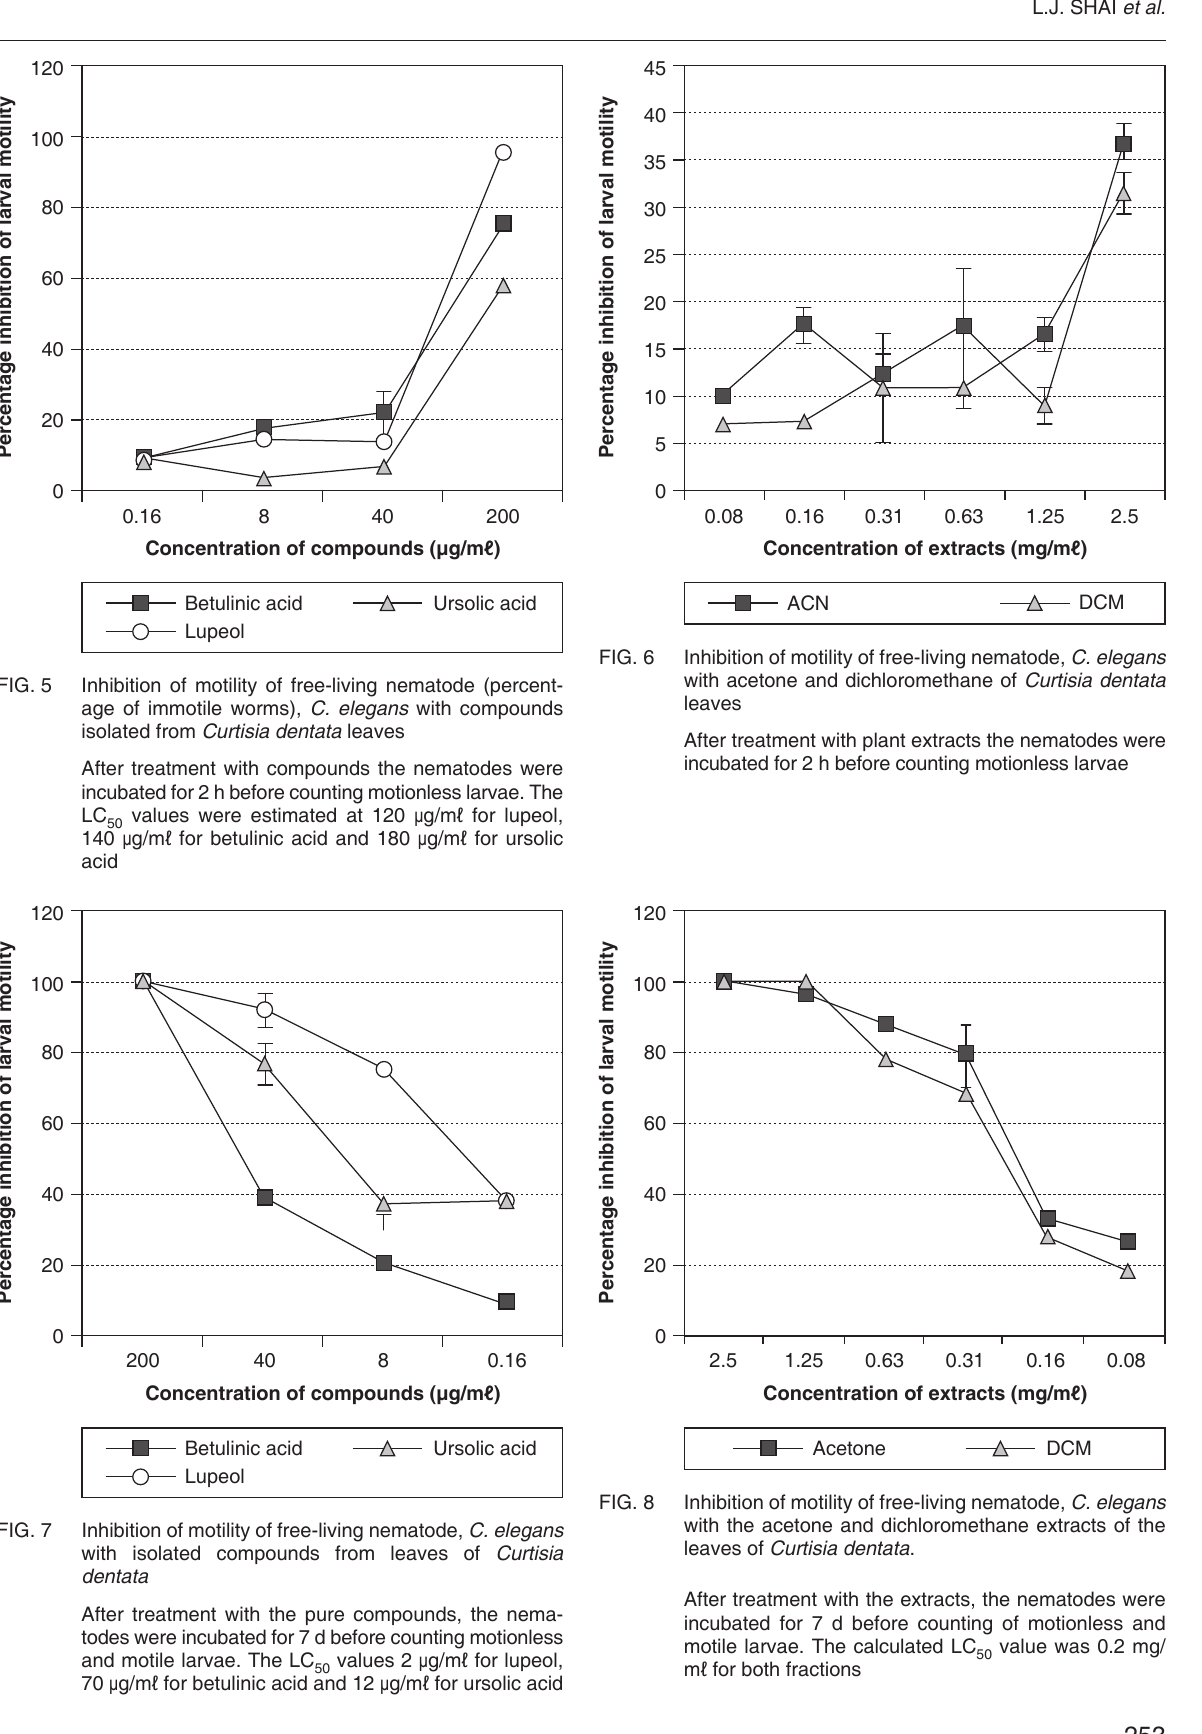
value was 0.2 mg/ 50